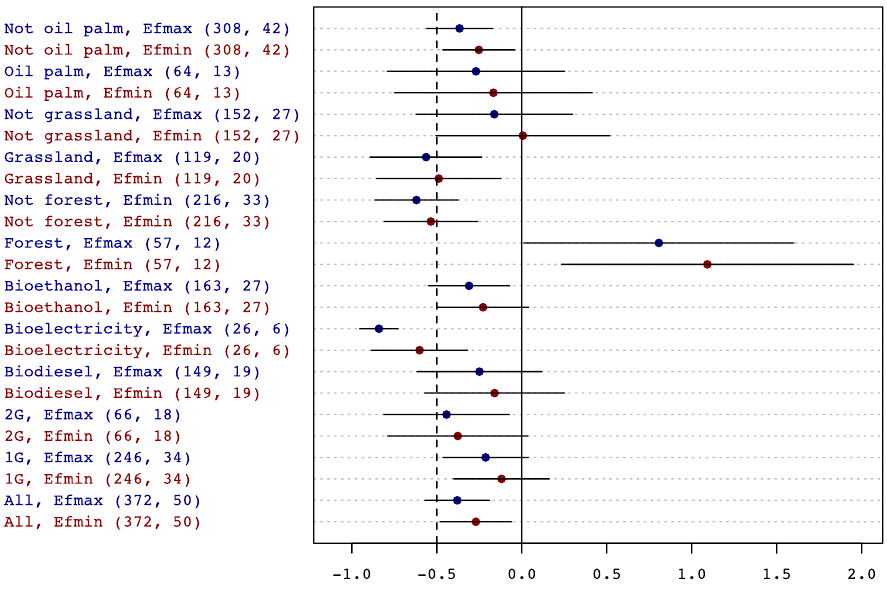
Figure 1. Estimated values of the mean effect-size R for different groups of bioenergy scenarios, using the minimum (Efmin) or maximum (Efmax) reference values for the GHG emissions of the fossil counterfactual. The horizontal bars depict 95% confidence intervals. The number of scenarios and the number of articles used in each group are given in brackets. The dotted line corresponds to a 50% GHG reduction level. Key to groups: ‘All’: all scenarios; ‘1G’ and ‘2G’: 1 st and 2 nd generation biofuels; ‘Forest’: forest as initial land-use; ‘Grassland’: grassland (including degraded pastures) as initial land-use; ‘Palm Oil’: biodiesel from palm oil; ‘Biodiesel’: production of biodiesel; ‘Bioelectricity’: production of bioelectricity; ‘Bioethanol’: production of